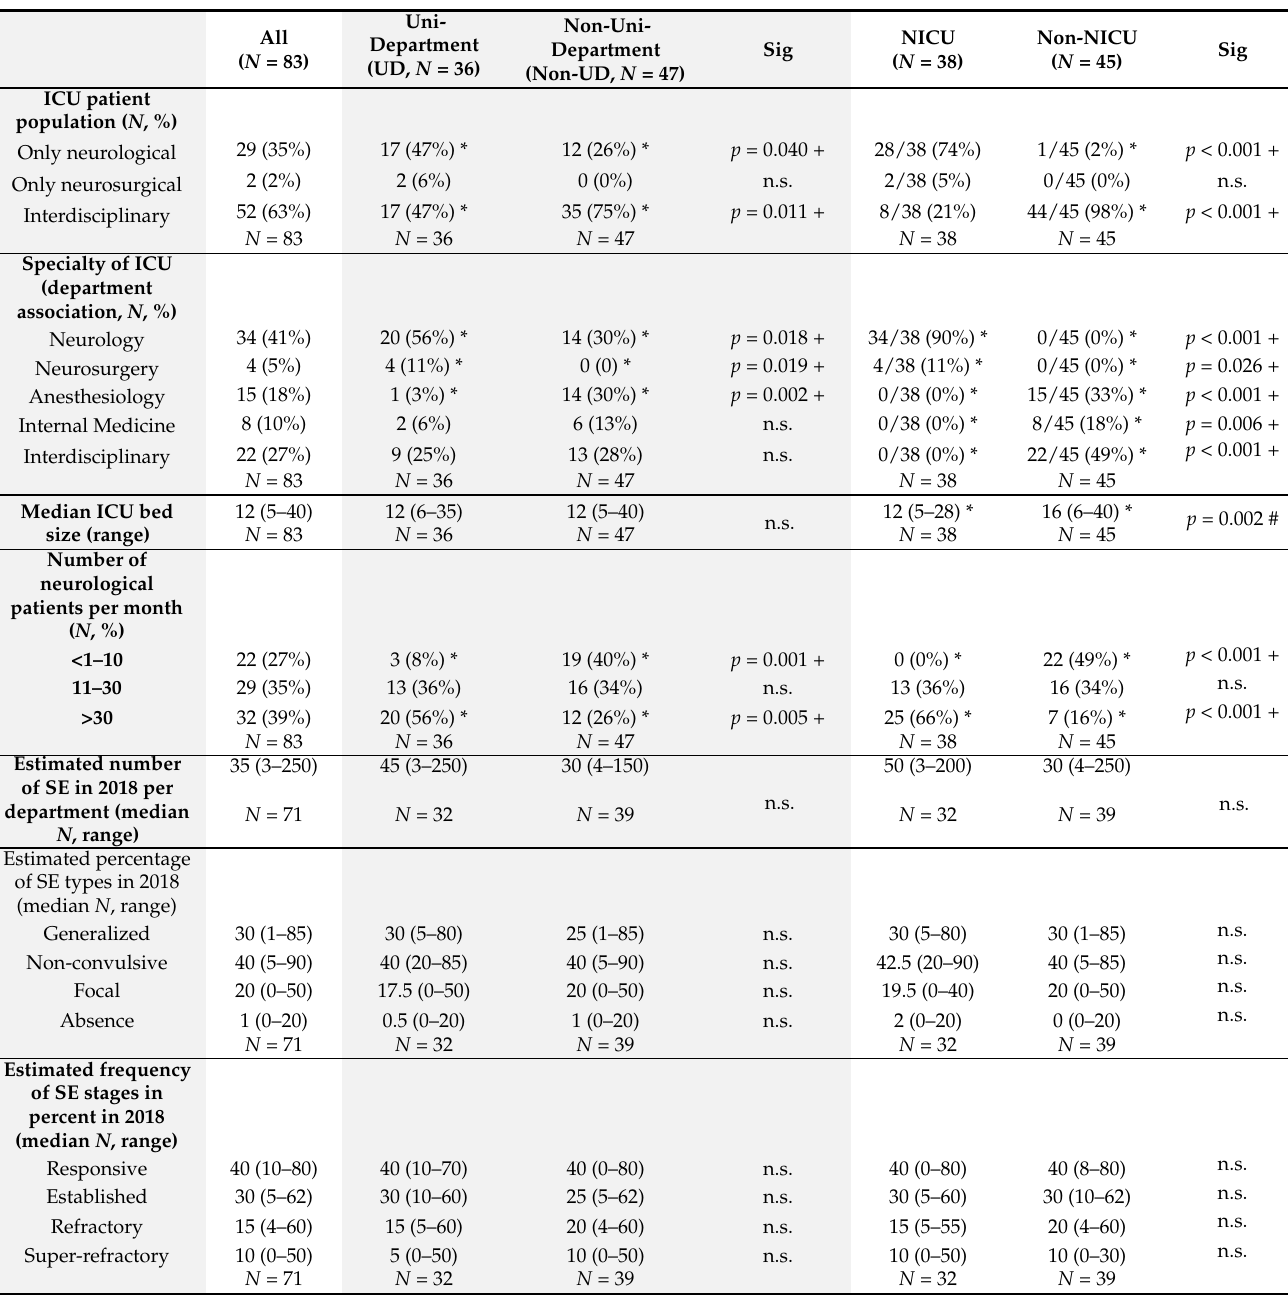
Table 1. Characteristics of the participating departments and